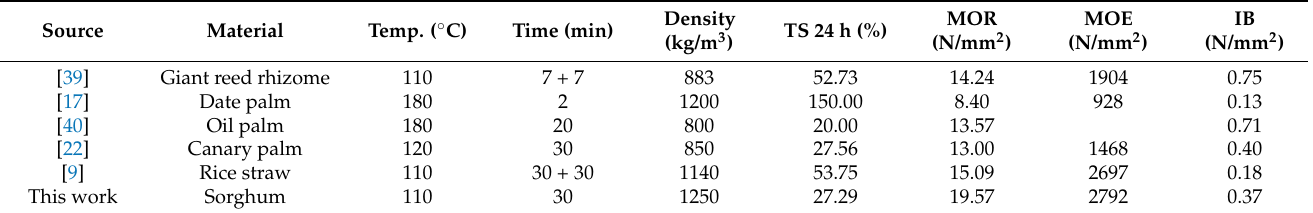
Table 5. Properties obtained for binderless particleboards made from vegetable